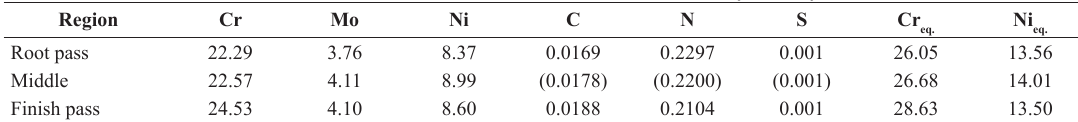
and Ni calculated according to 12 . eq. eq